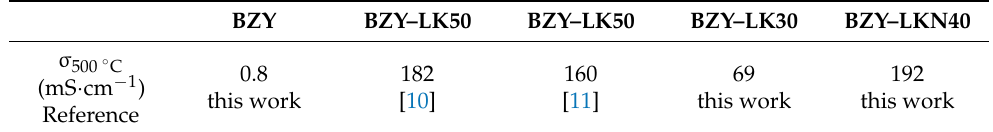
Table 3. Conductivities of BZY and BZY–MC composites at 500 ◦ C under air.